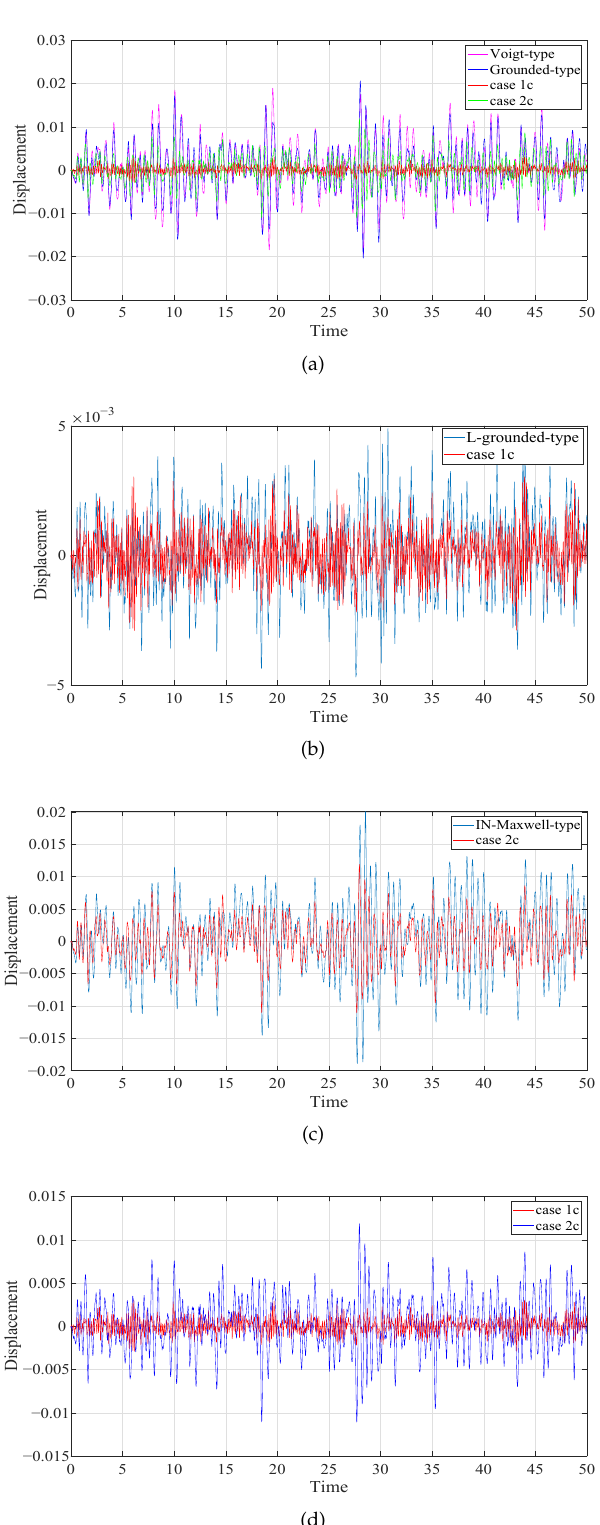
Figure 15. Comparison of the time histories of the primary system with different DVAs: ( a ) Com- parison of classical DVAs with our results. ( b ) Comparison of L-grounded-type DVA with case 1c. ( c ) Comparison of IN-Maxwell-type DVA with case 2c. ( d ) Comparison of case 1c with case